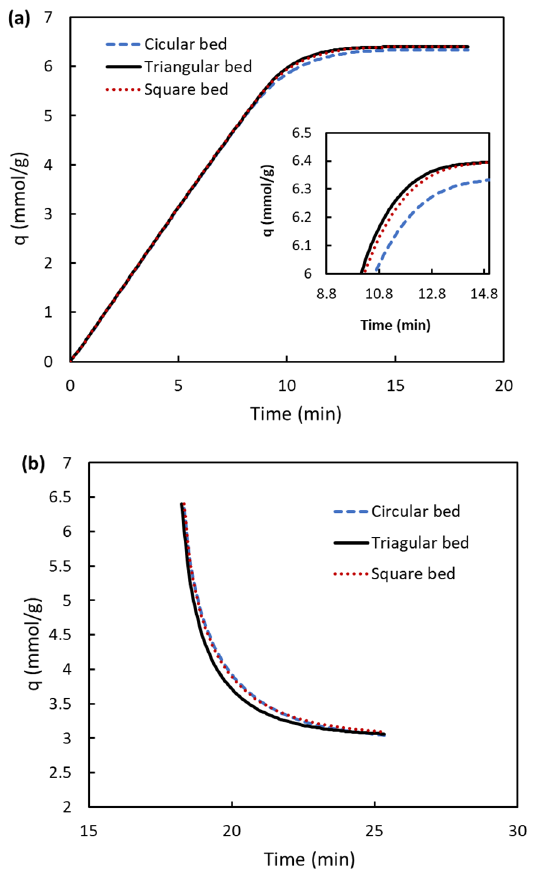
Figure 6. CO 2 adsorption uptake during ( a ) adsorption process and ( b ) desorption process for the investigated beds.